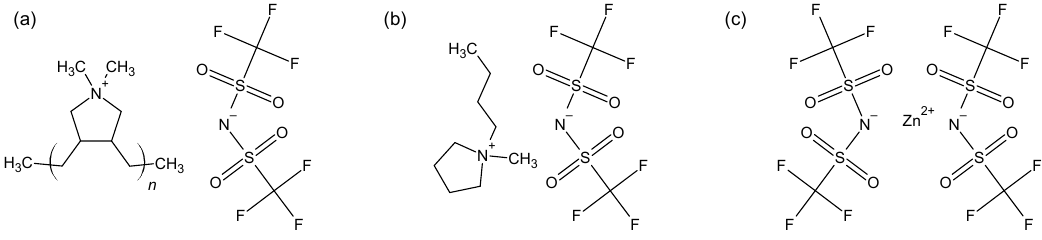
Figure 1. Chemical structures of PIL/IL/Zn 2+ composite constituents: ( a ) poly-(diallyldimethyl ammonium) bis(trifluoromethylsulfonyl)imide (P[DADMA][Tf 2 N]); ( b ) N-butyl-N-methyl pyrrolidinium bis(trifluoromethylsulfonyl)imide ([Pyrr 14 ][Tf 2 N]) and ( c ) zinc